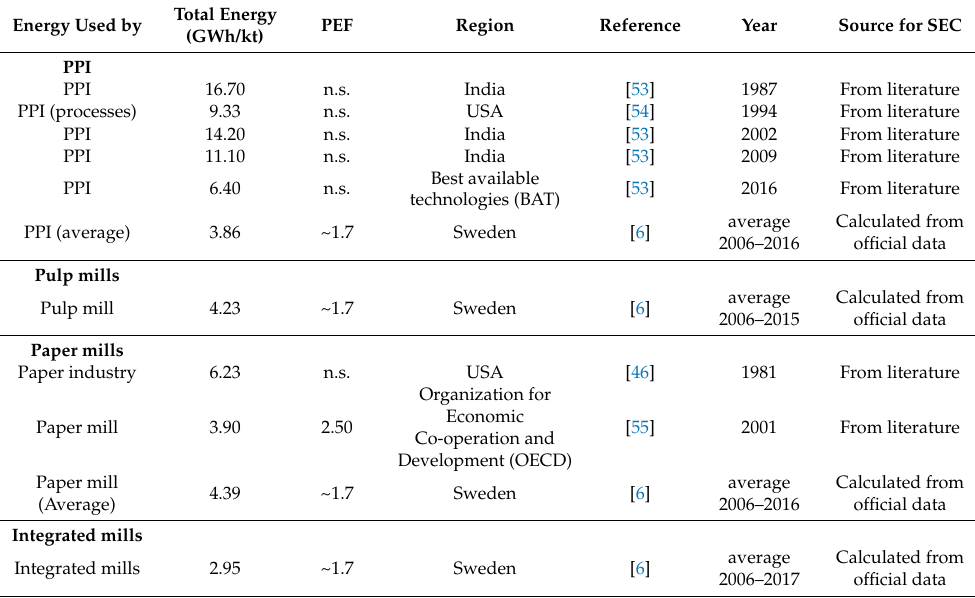
Table 4. Examples of SEC for the pulp and paper industry (PPI). “n.s.” means that the PEF was not specified in the references and was therefore recalculated as presented in Section 3.